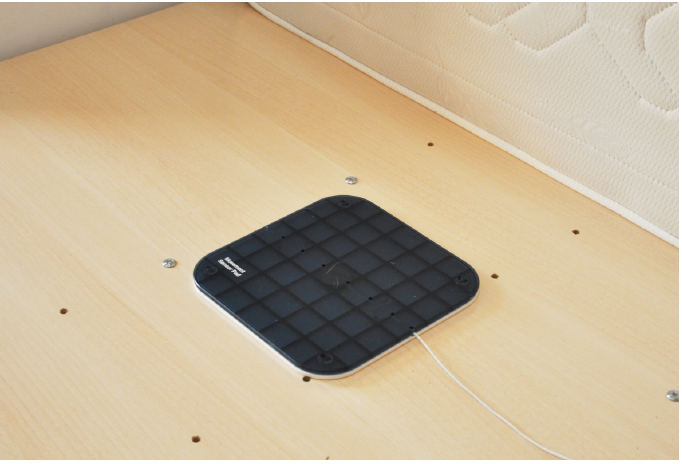
Figure 1. Piezoelectric-based sensor placed under the mattress to detect movements in bed.